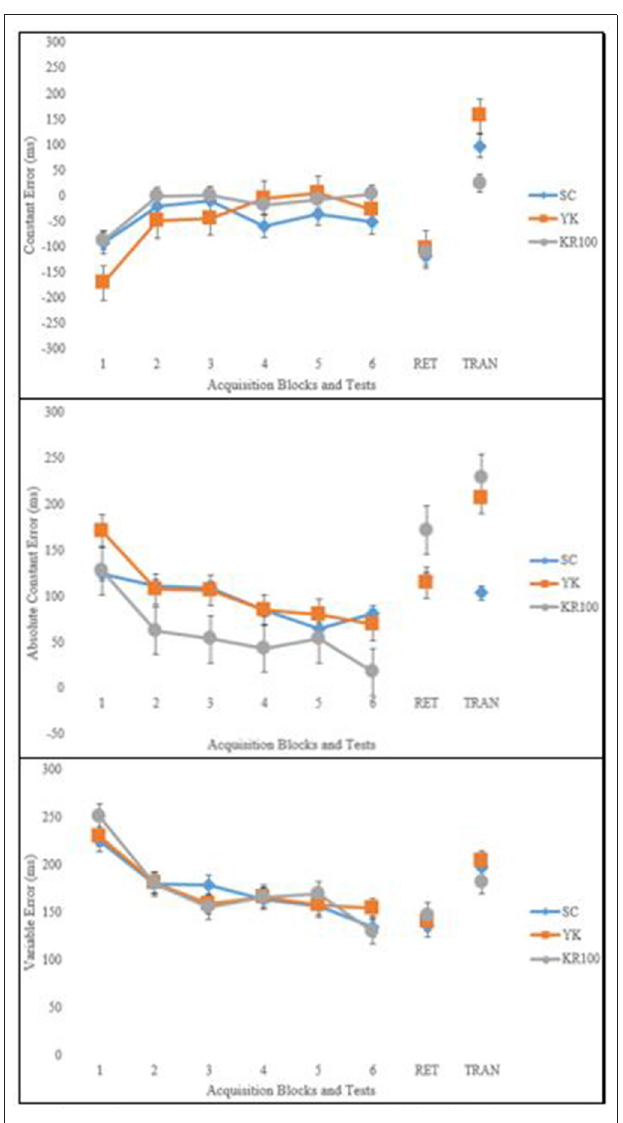
FIGURE 2 | Mean (with SD error bars) CE, ACE, and VE scores for self-control (SC), yoked (YK), and 100% feedback (KR100) groups during acquisition, retention, and transfer phases